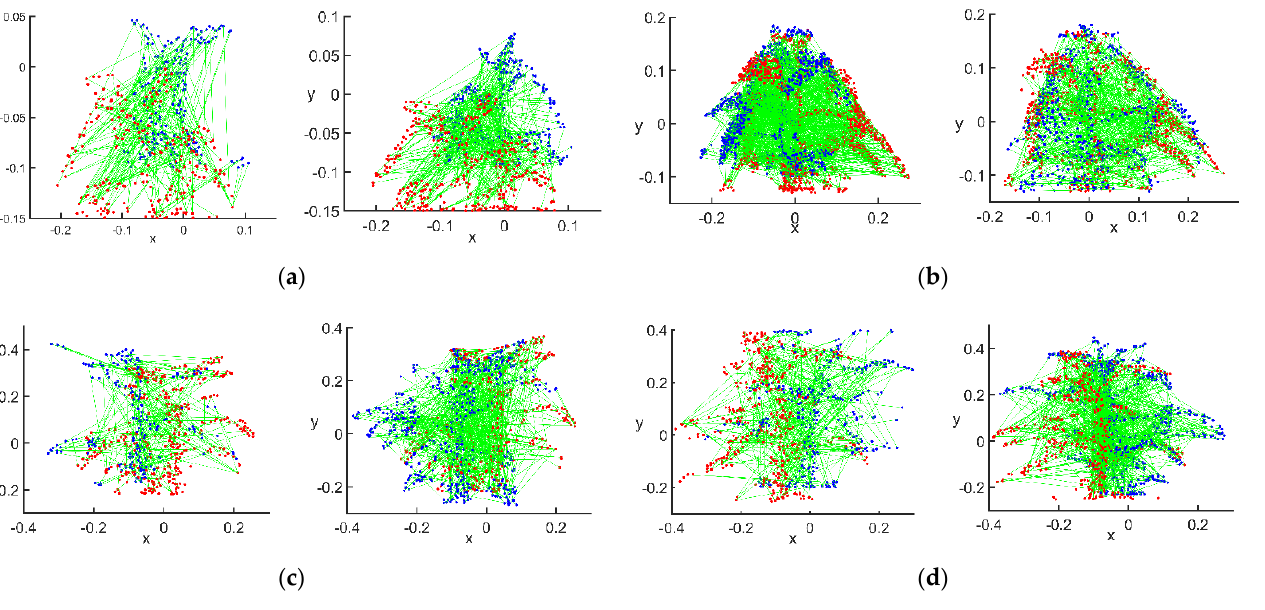
Figure 9. Initial matching effect of feature points: ( a ) flowering stage; ( b ) podding stage; ( c ) filling stage; ( d ) mature stage.